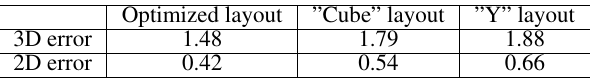
Table 3. Four base stations with different layouts average positioning error table.